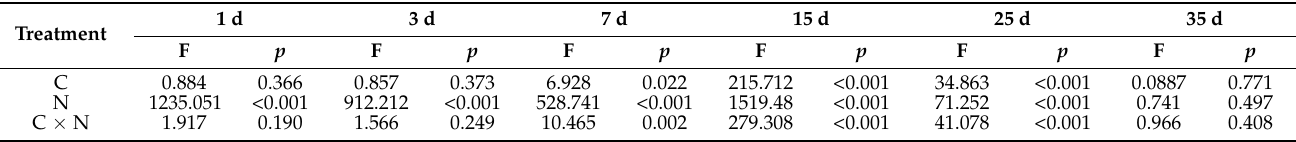
Table 6. ANOVA of the effects of returning straw and the nitrogen application rate on the ammonium nitrogen content in saline